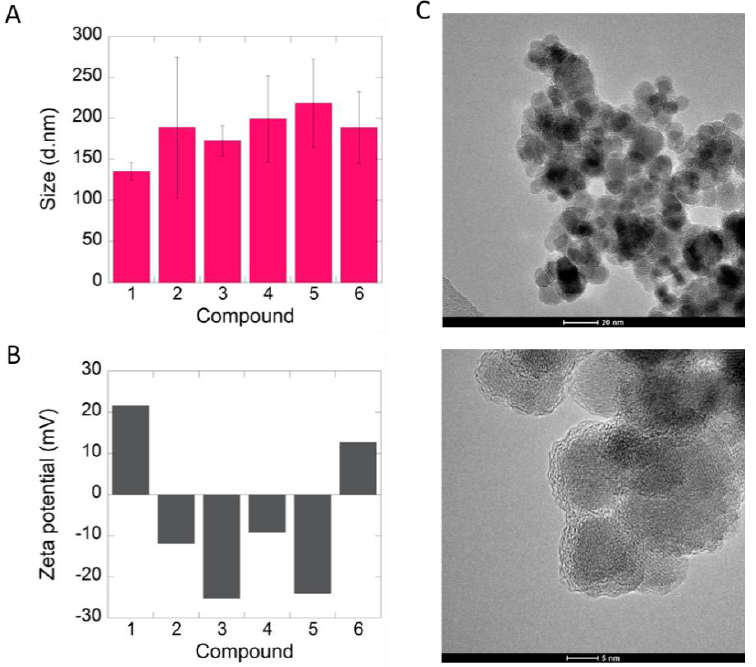
Figure 3. ( A ) DLS and ( B ) zeta potential results of modified iron oxide particles: 1 — MNP@NH 2